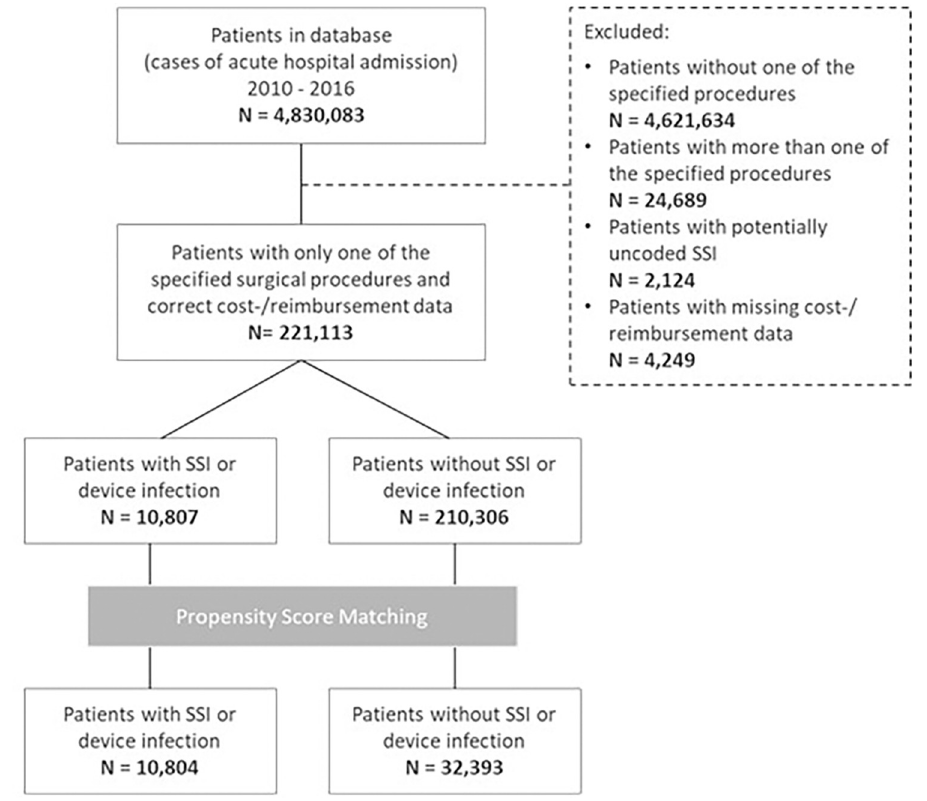
Fig 1. Flow diagram for case numbers,